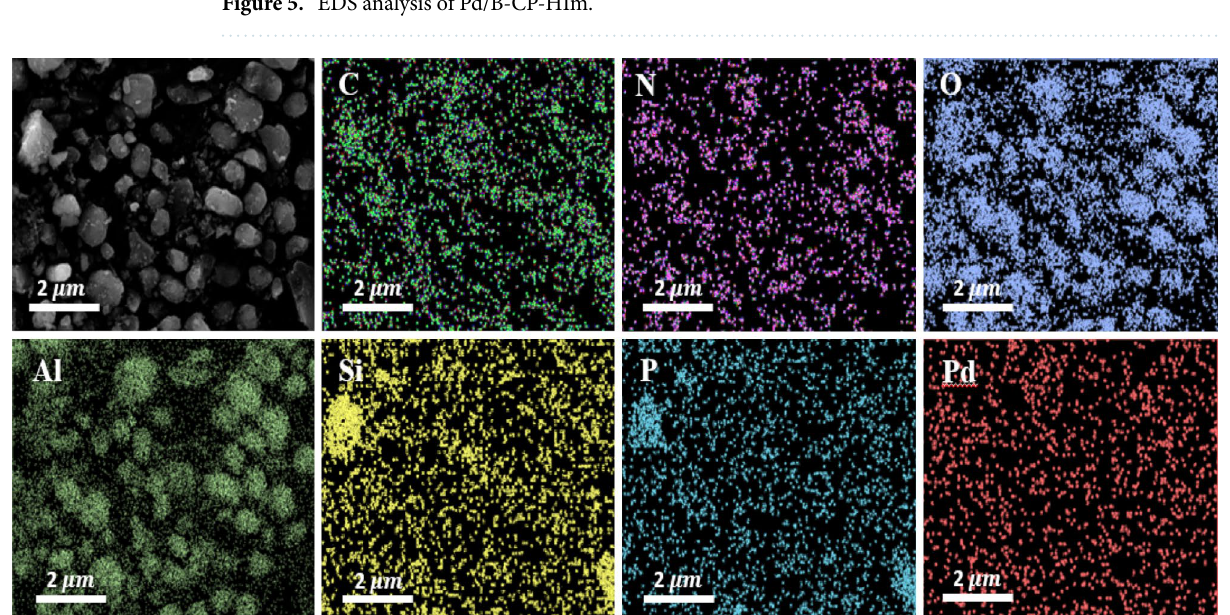
Figure 5. EDS analysis of Pd/B-CP-HIm.